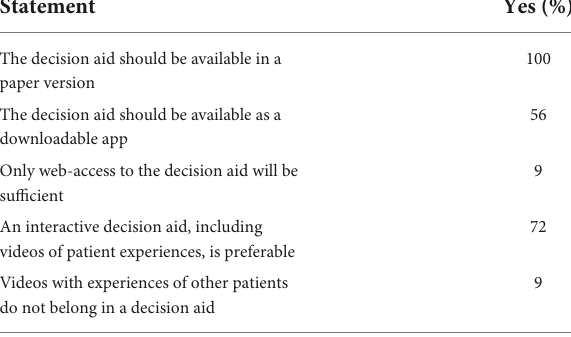
Frontiers in Cardiovascular